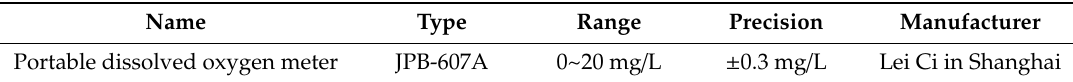
Table 1. Detailed description of the portable dissolved oxygen meter.